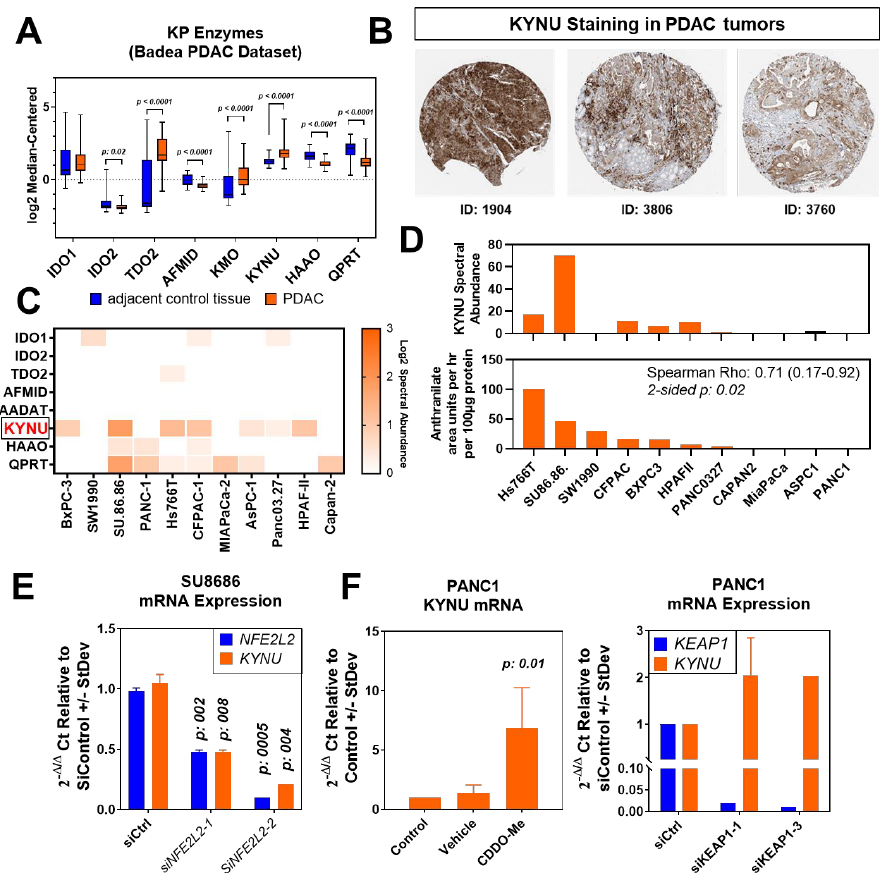
Figure 2. NRF2 regulates KYNU expression in pancreatic cancer cells. ( A ) mRNA expression of KP enzymes in pancreatic tumors and adjacent control tissues. The gene expression data were derived from the Badea study [10]. Statistical significance was determined by the 2-sided Wilcoxon matched- pairs signed rank test. ( B ) Representative immunohistochemical staining of KYNU in pancreatic tumors. Data were derived from the ProteinAtlas. ( C ) Protein abundance (spectral abundance) of KYNU in whole cell lysates of 11 pancreatic cancer cell lines analyzed by mass spectrometry. ( D ) Bar plots showing the association between whole-cell-lysate KYNU protein expression and rates (area units per hour per 500 µ g of protein) of KYNU-derived anthranilate accumulation in the conditioned medium of the respective pancreatic cancer cell lines. ( E ) Relative mRNA expression of KYNU following siRNA-mediated knockdown of NFE2L2 in SU.86.86 pancreatic cancer cells. ( F ) Relative mRNA expression of KYNU following treatment of KYNU-low PANC1 pancreatic cancer cells with the NRF2 agonist CDDO-Me (left panel) or following siRNA-mediated knockdown of KEAP1 (right